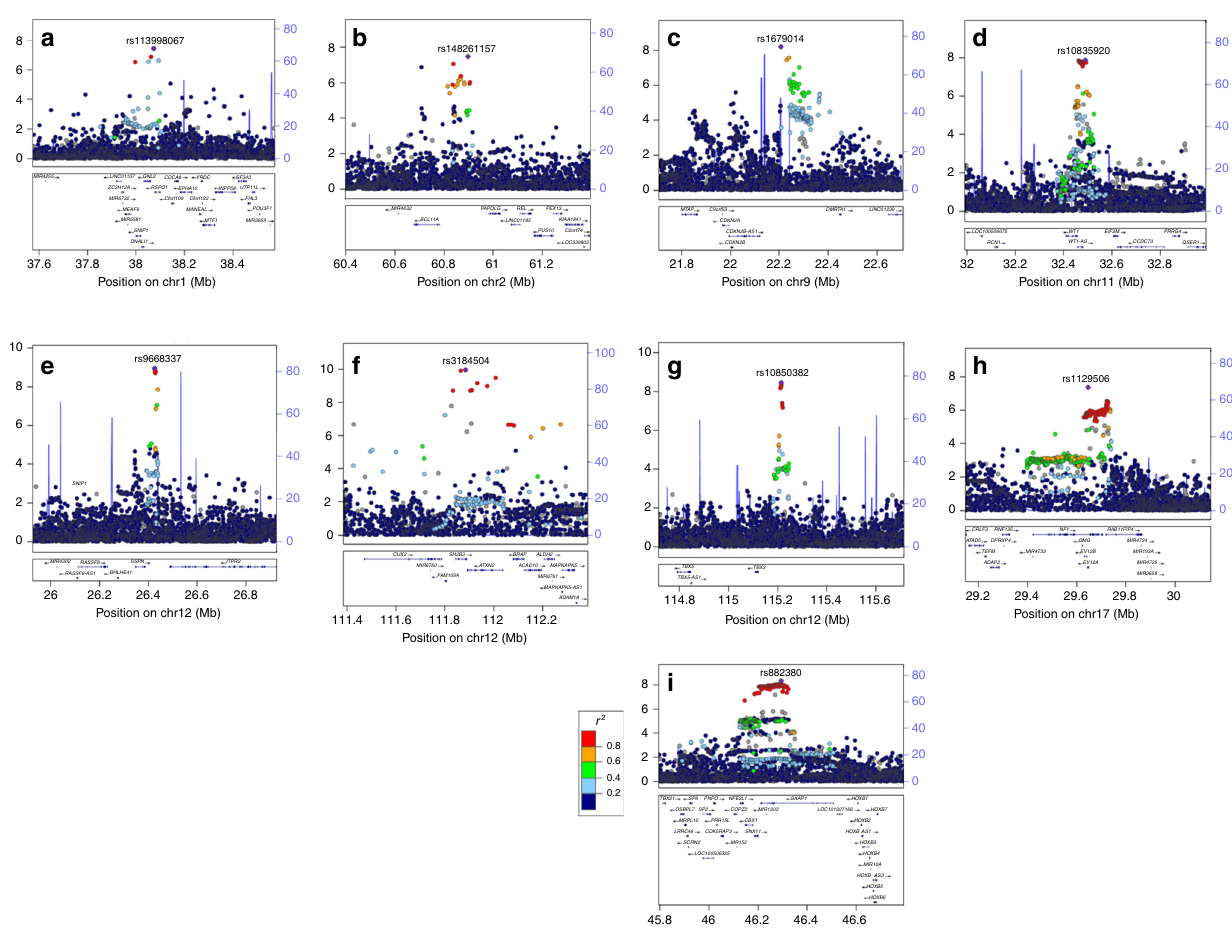
Fig. 2 Regional association plots for the nine novel endometrial cancer loci. – log 10 ( p ) from the fi xed-effects meta-analysis is on the left y axis, recombination rate (cM/Mb) is on the right y axis (plotted as blue lines). The color of the circles shows the level of linkage disequilibrium between each variant and the most signi fi cantly associated variant (purple diamond) ( r 2 from the 1000 Genomes 2014 EUR reference panel — see key). Genes in the region are shown beneath each plot. a 1p34.3, b 2p16.1, c 9p21.3, d 11p13, e 12p12.1, f 12q24.11, g 12q24.21, h 17q11.2, i